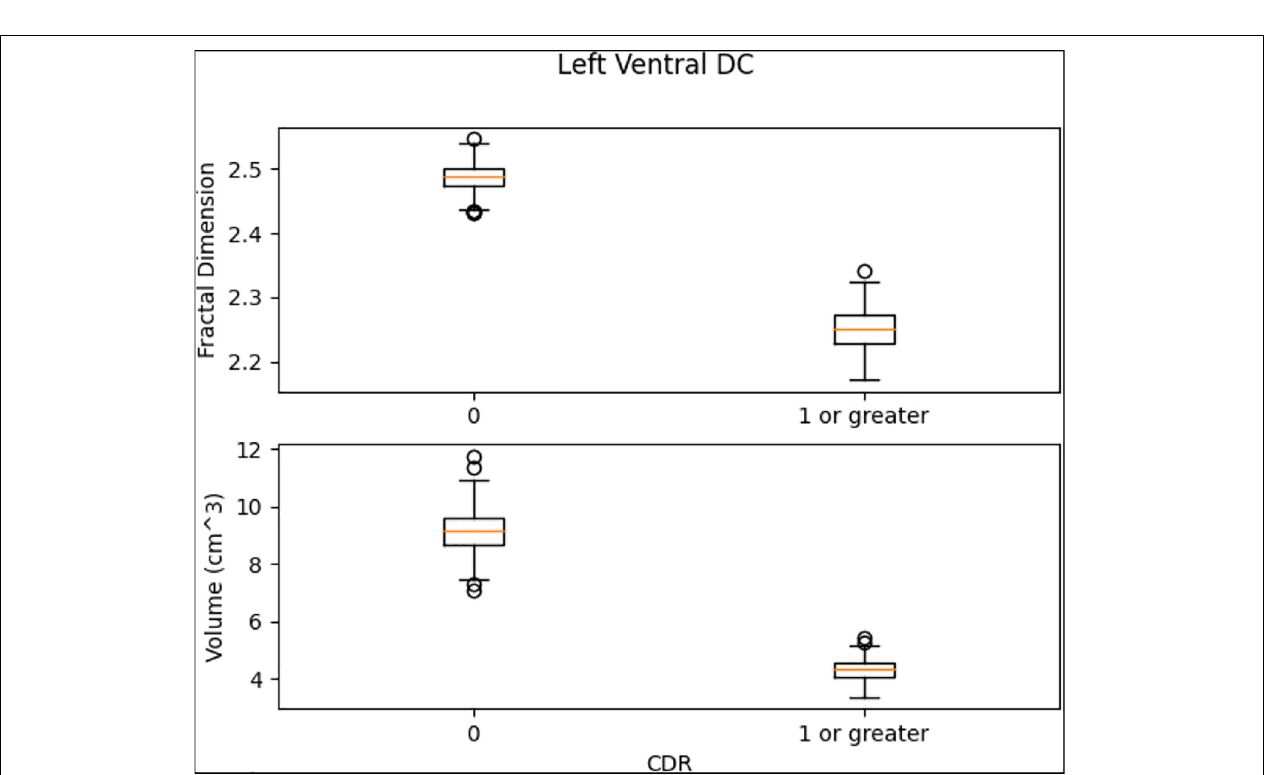
FIGURE 15 | The validation plot. It shows that for a training sample of approximately 480, maximum accuracy with no overfitting is achieved. With FD and Volume, the two groups are separated efficiently with 99.5% accuracy.